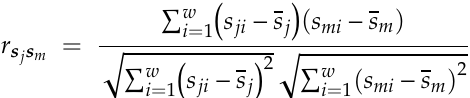
Figure 4. Daily dynamics of the 30-min load data observed between 17 August (Monday) and 24 August (Sunday) 2009.